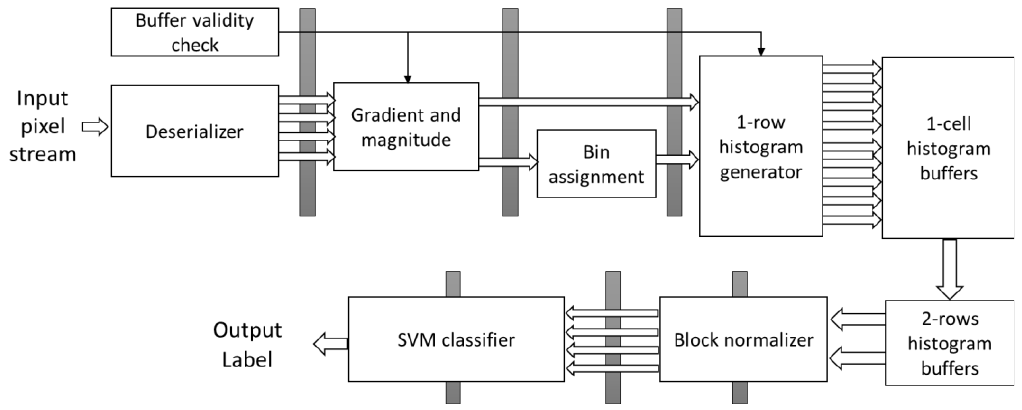
Figure 5. The overall diagram of the HOG-SVM core.